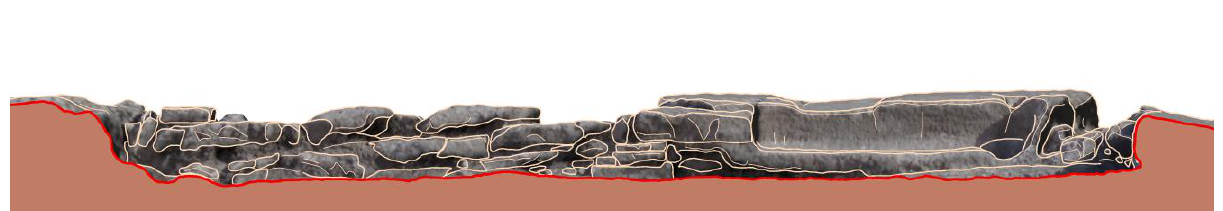
Figure 8. Cross-section of the workshop: vectorization on mesh with photographic